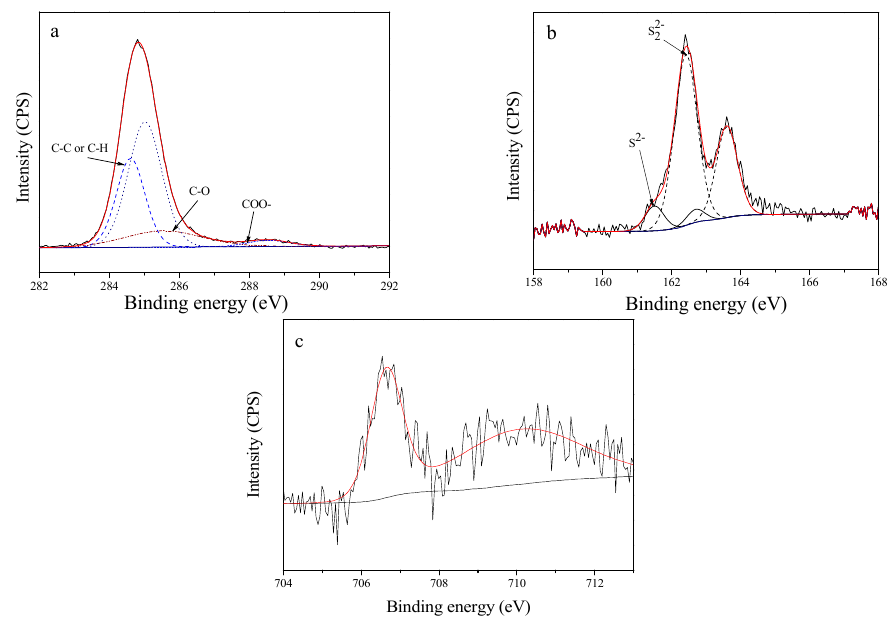
Figure 7. Carbon 1s ( a ), sulfur 2 p ( b ), and iron 2 p 3/2 ( c ) XPS spectra of pyrite (1 0 0) before adsorption of cysteine.